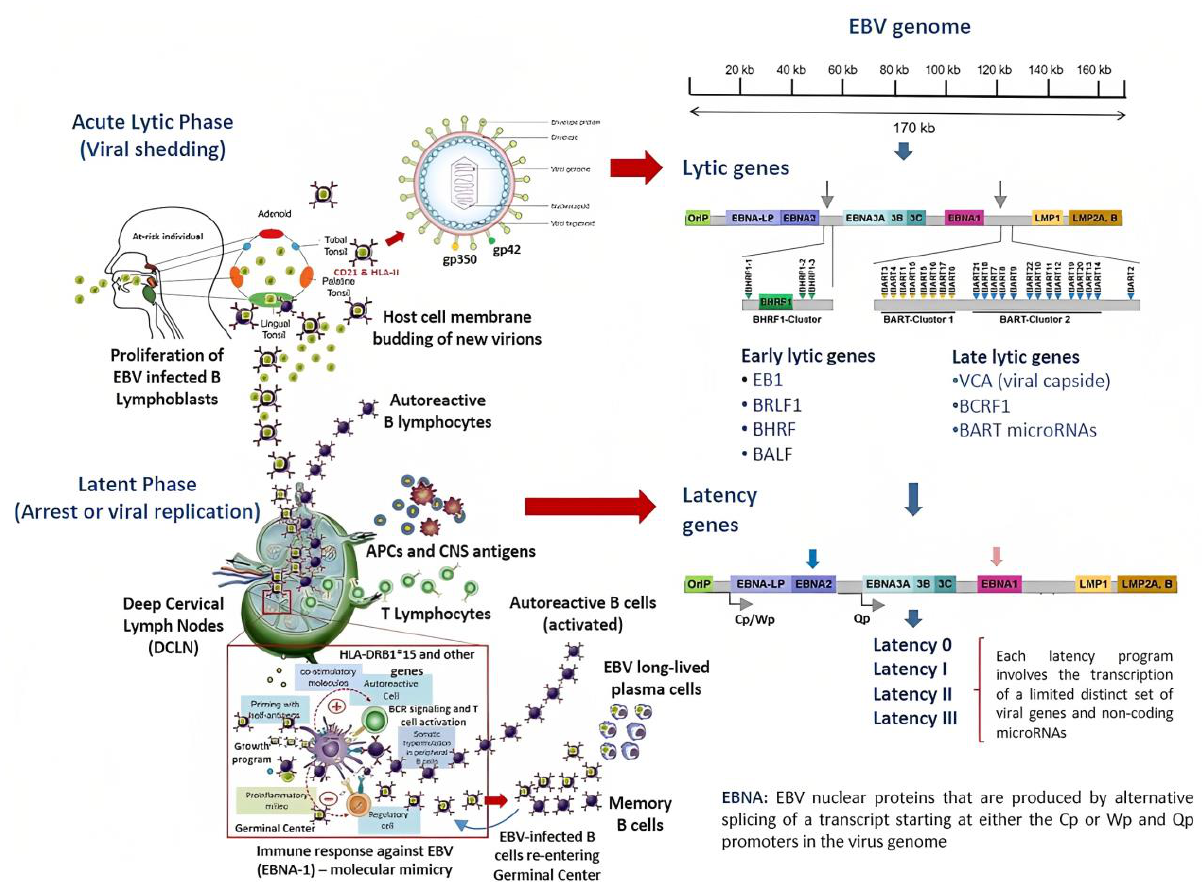
Figure 2. Life cycle and EBV-gene expression during acute and chronic infection. EBV is transmitted by saliva. Epithelial cells and naïve B cells in the local lymphoid tissue can be infected through specific receptors. Early after infection, EBV starts reprogramming the B cell, inducing its rapid proliferation and the assembling of new virions which bud from the cell membrane. These events can occur during acute infection (lytic phase) or after EBV reactivation. This phase is also characterized by the expression of a specific set of EBV genes. After this stage, the virus sequesters the infected B cells and directs them towards the germinal centers inside the secondary lymphoid organs. There, during the latent phase of infection, EBV decides the fate of infected cells independently from the BCR signaling pathway or the activation by T cells. The latent phase is made up of four latency viral programs each defined by the expression of a unique set of EBV genes. However, the entire EBV genome is transcribed only in the type III latency program, which is thought to be related with MS onset. Finally, it may be postulated that EBV-infected B cells can also re-enter the germinal center. There, EBV may execute fine-tuning in the host gene expression of infected B cells while it efficiently manipulates the antiviral immune response. These mechanisms have been closely linked with the onset of lymphoproliferative disorders. BCR: B-cell receptor.